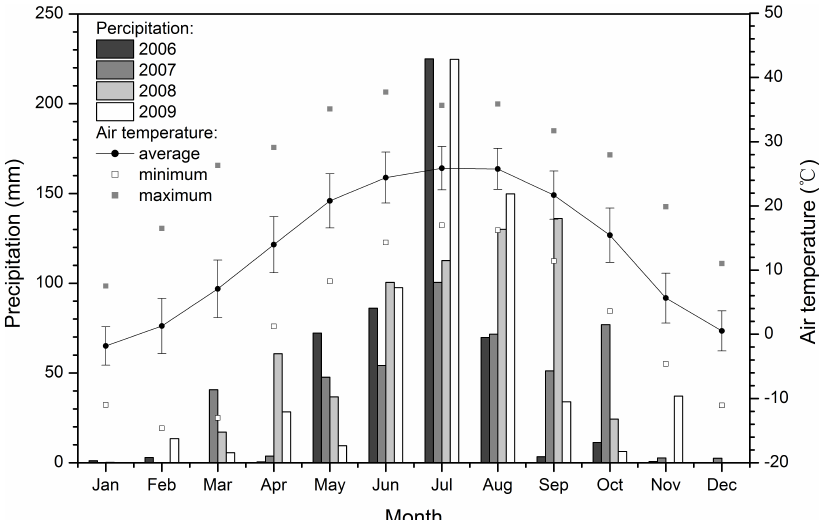
Fig. 2. Monthly precipitation for each study year separately and monthly air temperature for the whole measurement period measured at Caoyang weather station. The open and solid square points indicate minimum and maximum air temperature. The error bars indicate one standard